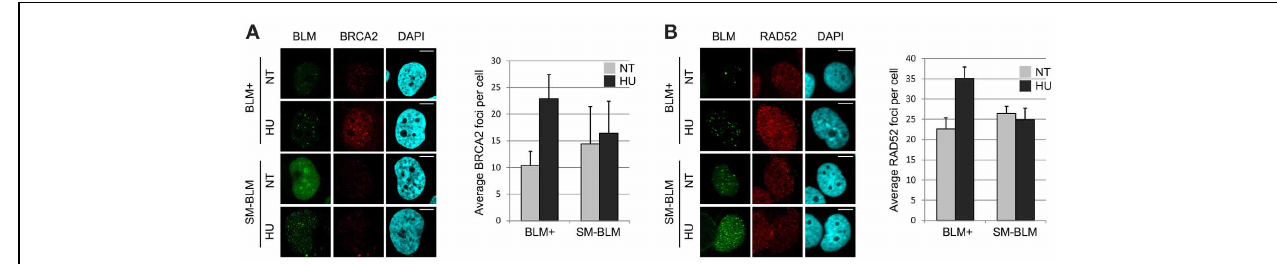
FIGURE 1 | Mediator accumulation at stalled replication forks is impaired in SUMO-mutant BLM cells. (A) Immunofluorescence images of BLM + and SM-BLM cells untreated (NT) or treated with 0.5mM HU for 24h (HU) and stained for BRCA2, with graphical representation of mean numbers of BRCA2 foci. (B) Same as (A) but stained for RAD52, with graphical representation as in (A) . Two independent experiments were carried out on each of two BLM + and